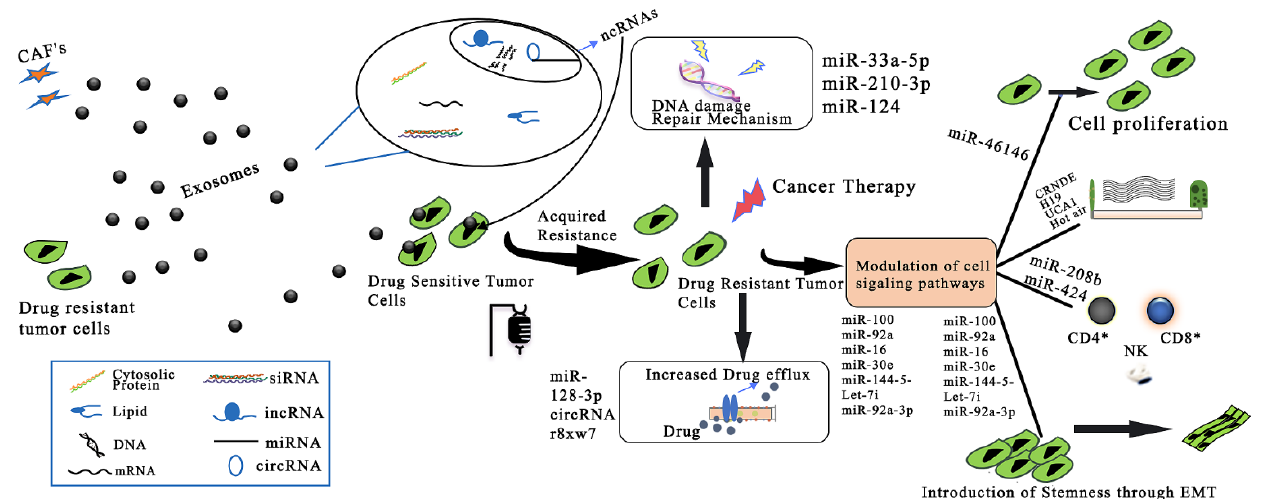
Figure 3. Exosomal ncRNA-related mechanisms implicated in CRC drug resistance. CAFs: cancer- associated fibroblasts; ncRNAs: noncoding RNAs; miRNA: microRNA; circRNA: circular RNA; lncRNA: long noncoding RNA. Adapted and modified from [75] under the Creative Commons license.